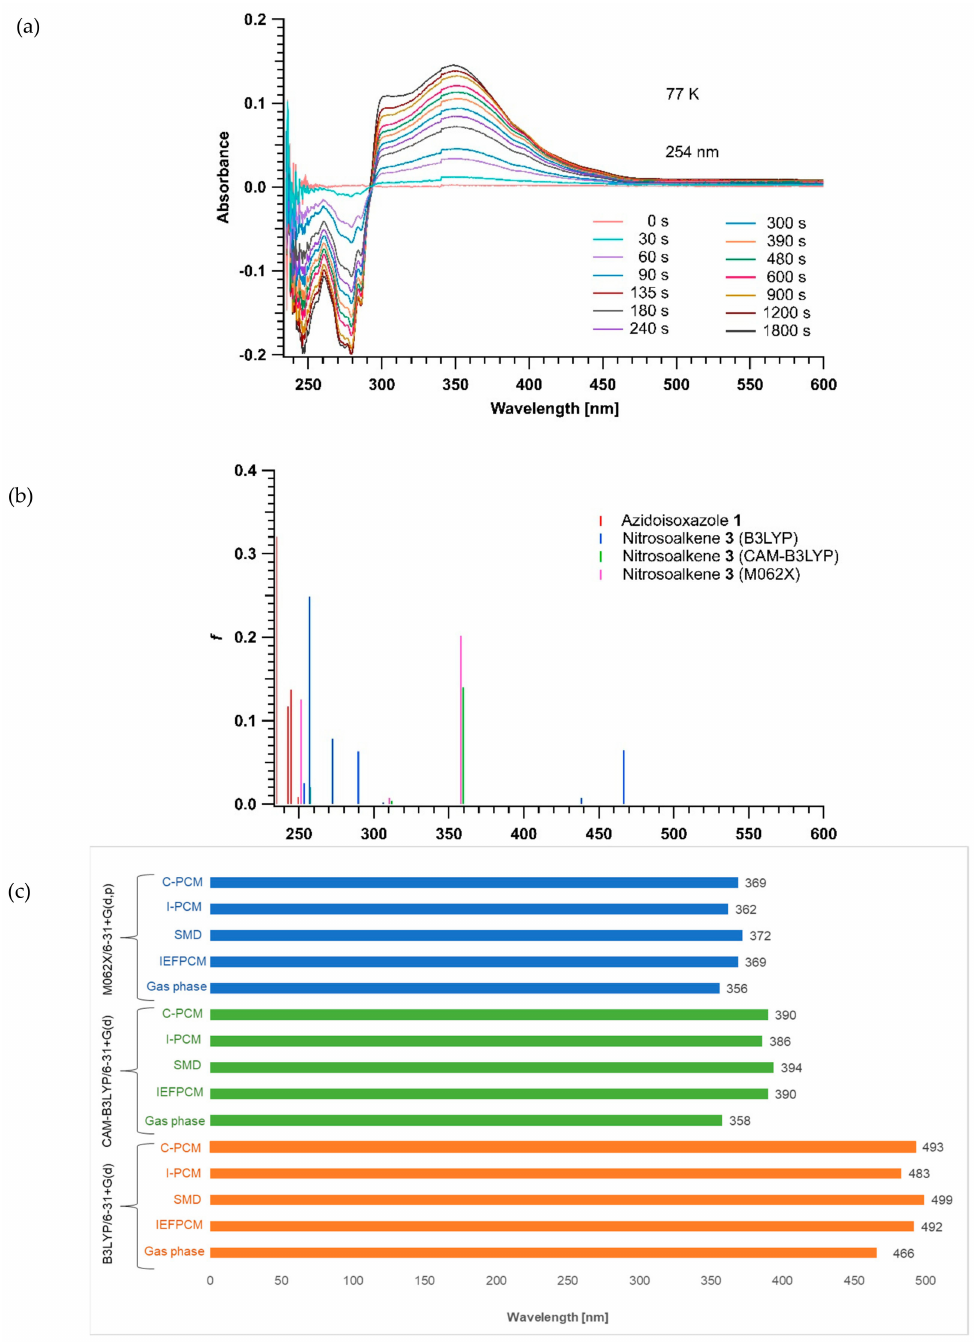
Figure 2. ( a ) Di ff erential UV-Vis absorption spectra as a function of irradiation time ( λ = 254 nm) of azidoisoxazole 1 in glassy 2-methyltetrahydrofuran (mTHF) at 77 K; ( b ) Calculated time-dependent density function theory (TD-DFT) absorption spectra of nitrosoalkene 3 using B3LYP / 6-31 + G(d), CAM-B3LYP / 6-31 + G(d), and M06-2X / 6-31 + G(d,p) using tetrahydrofuran (THF) as an implicit solvent with C-PCM and I-PCM solvation models; ( c ) Calculated TD-DFT absorption maxima of nitrosoalkene 3 above 300 nm using B3LYP / 6-31 + G(d), CAM-B3LYP / 6-31 + G(d), and M062X / 6-31 + G(d,p) in the gas phase and using THF as an implicit solvent with C-PCM, I-PCM, SMD, and IEFPCM solvation models. Time-dependent density function theory (TD-DFT) calculations of the absorption spectrum of nitrosoalkene 3 using the B3LYP / 6-31 + G(d) level of theory and basis set in the gas phase gave major electron transitions at 257 ( f = 0.2486), 272 ( f = 0.0781), 290 ( f = 0.0632), 438 ( f =